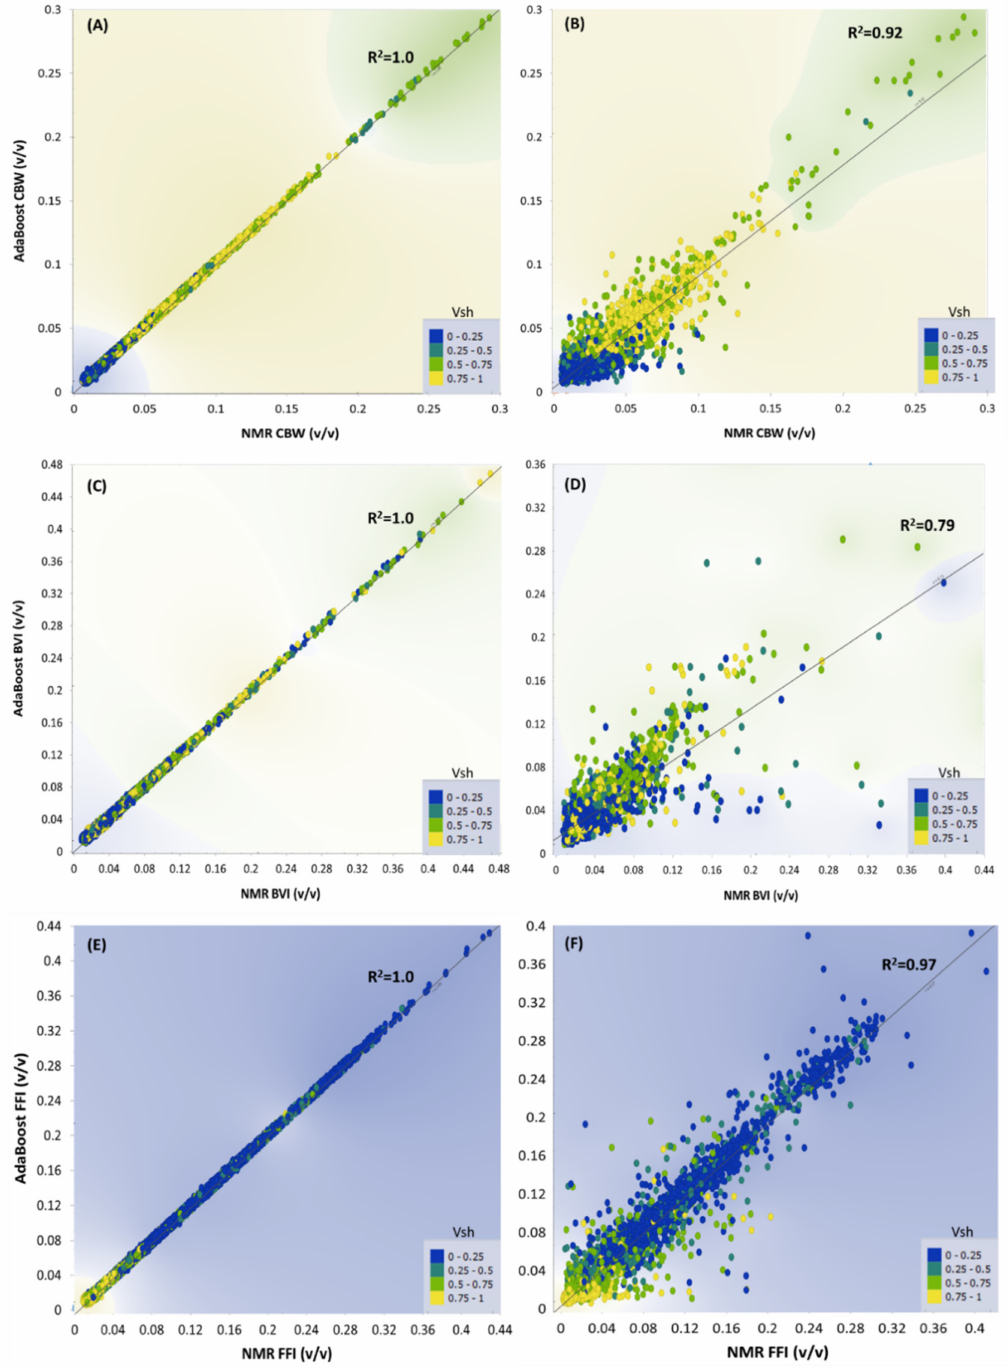
Figure 4. AdaBoost performance for prediction of CBW, BVI, and FFI in training ( A – E ) and blind ( B – F ) datasets,